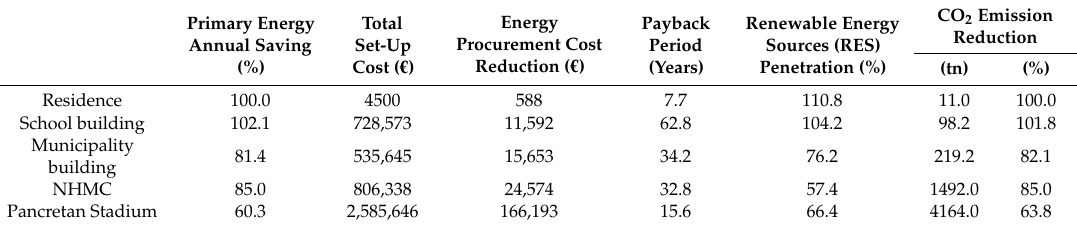
Table 10. Key Performance Indicators.